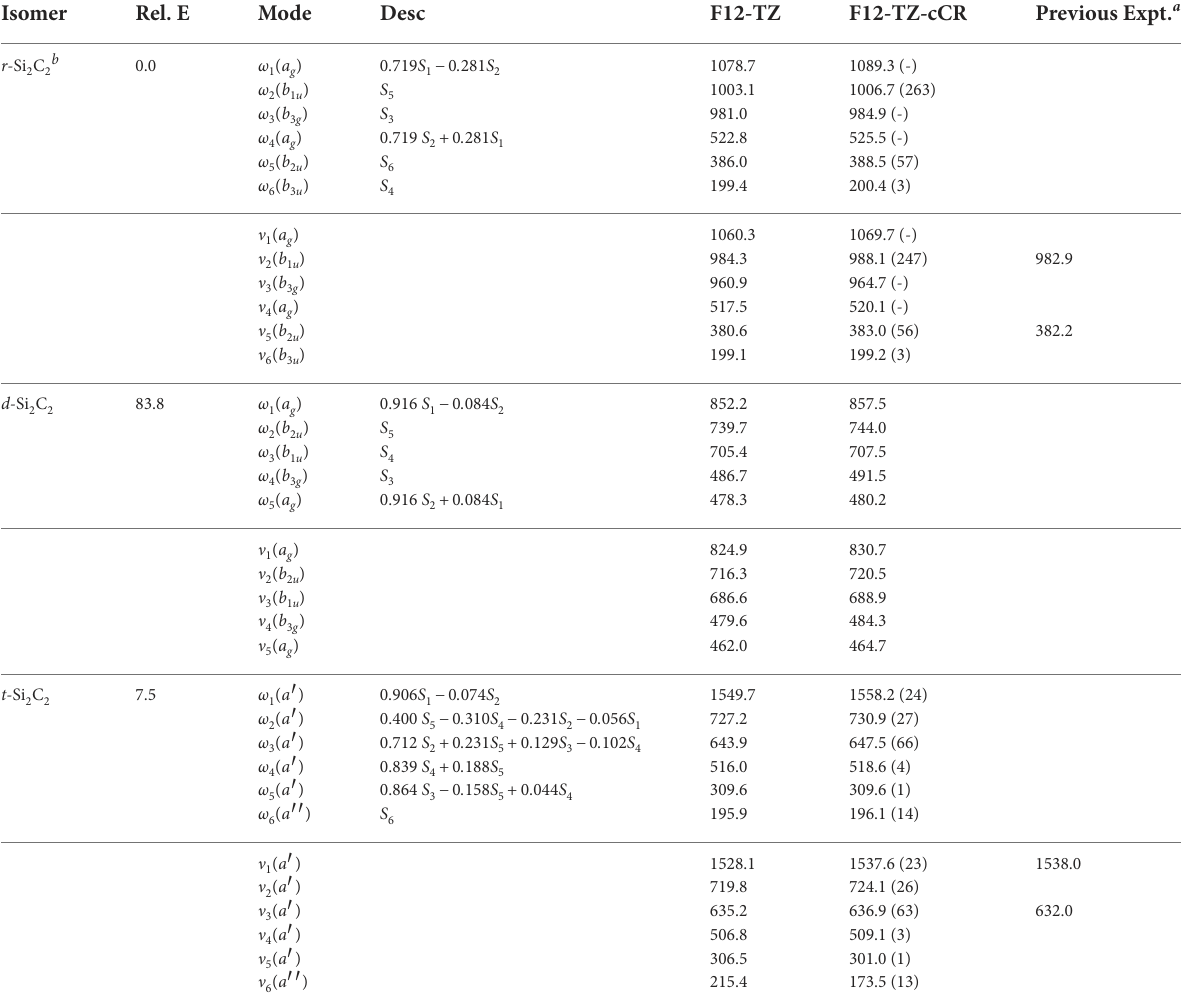
TABLE 5 Harmonic ( ω ) andFundamental ( ν ) VibrationalFrequencies(incm −1 )withIntensities(inkm mol −1 ,inParentheses)andRelativeEnergies(in kcal mol −1 )forSi 2 C 2 Isomers.Modedescriptions(Desc.)refertotheSICsinEqns.1-24.